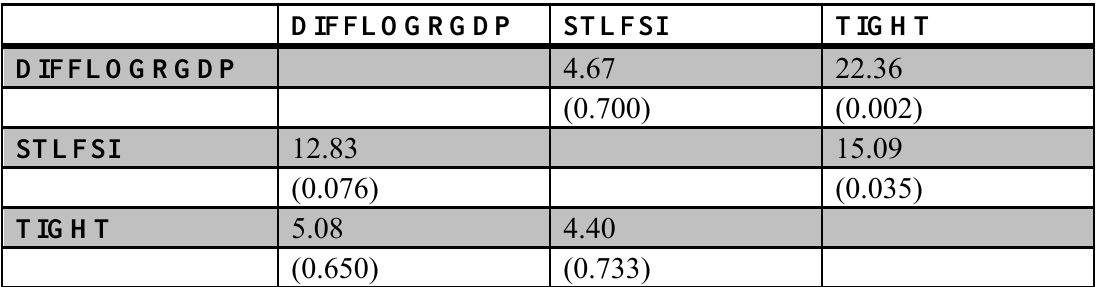
Table 2. Each statistic (not in parentheses) is the test for whether to column variable Granger causes the dependent variable in the row. The numbers in parentheses are p-values for the null of no